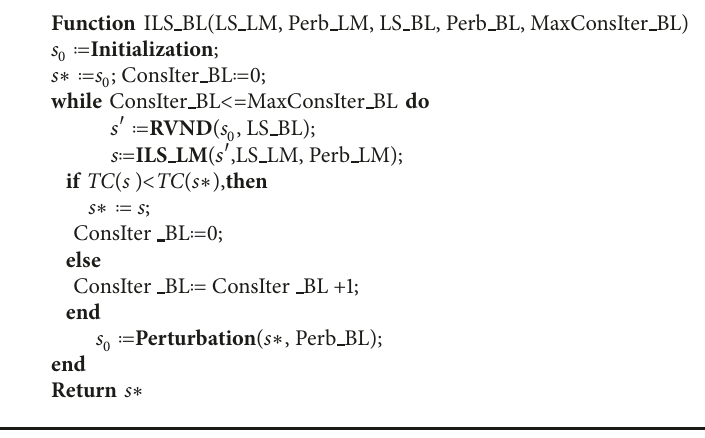
Algorithm 3: ILS for bi-level